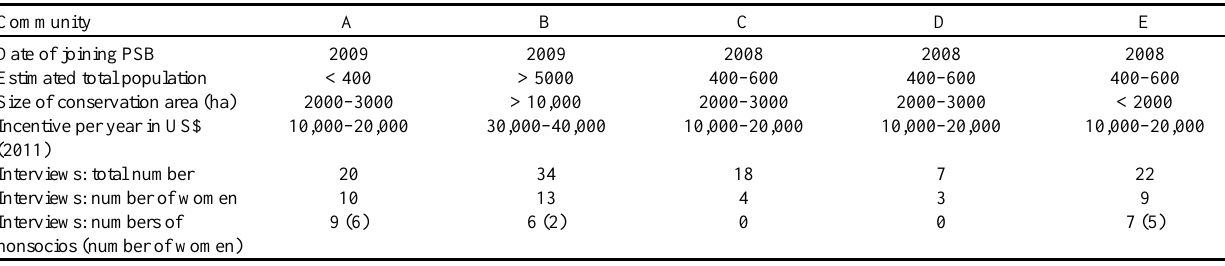
Table 2 . Community demographics and information. Source: PSB